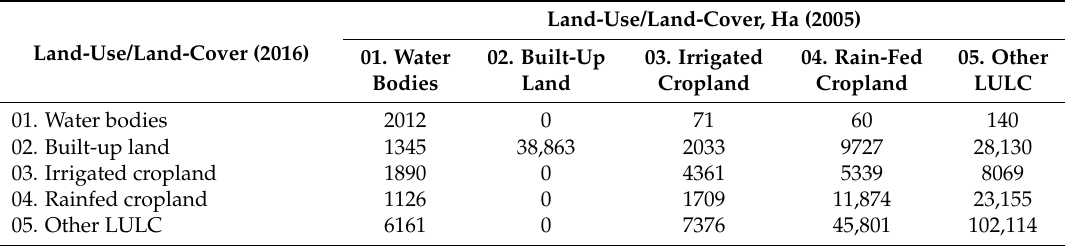
Table 7. Matrix of Land-use/land-cover (LULC) changes from 2005 to 2016.